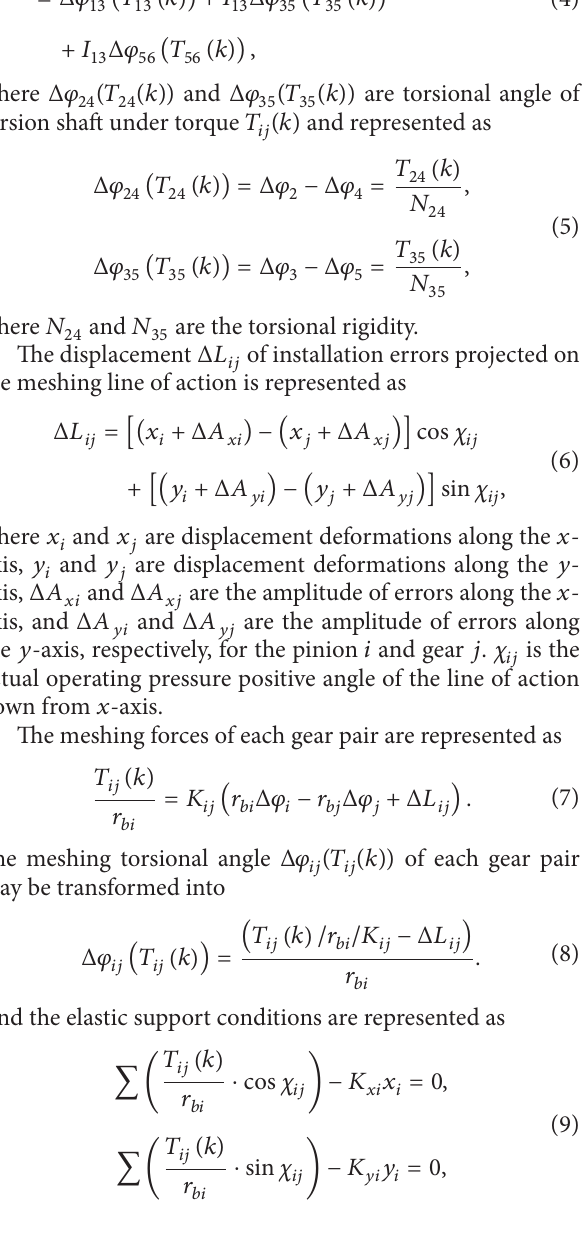
Figure 3: Torsional angle relationships among each gear.